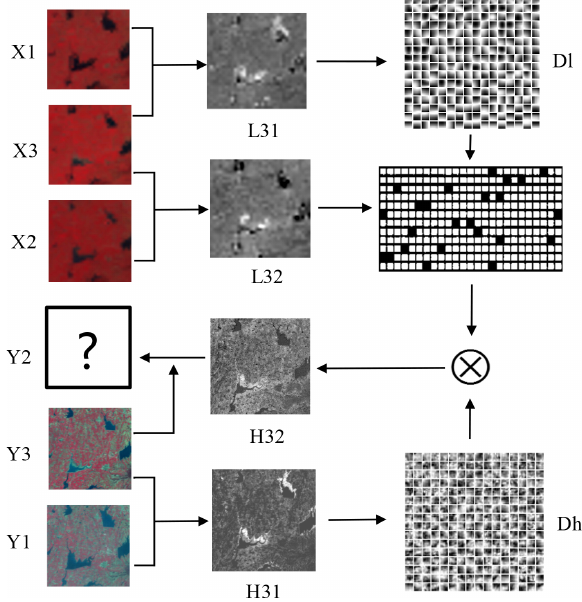
Figure 1. Block diagram of